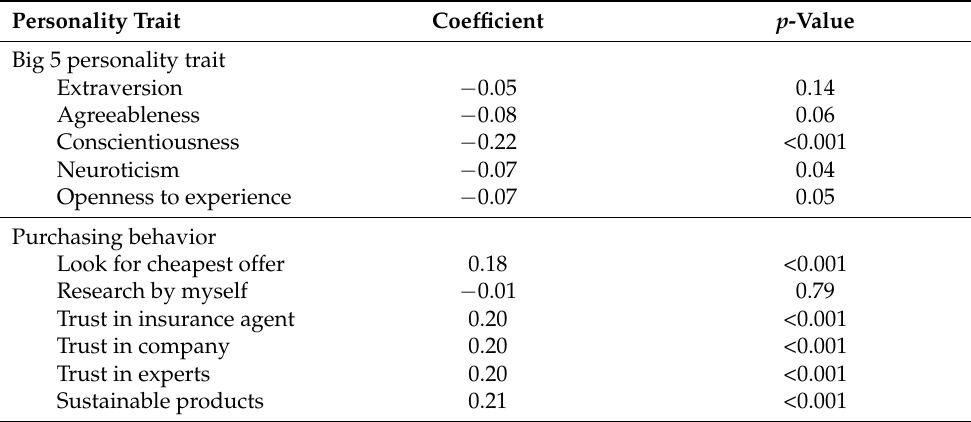
Table 3. Impact of personality type on the opinion on insurance communication on social media.